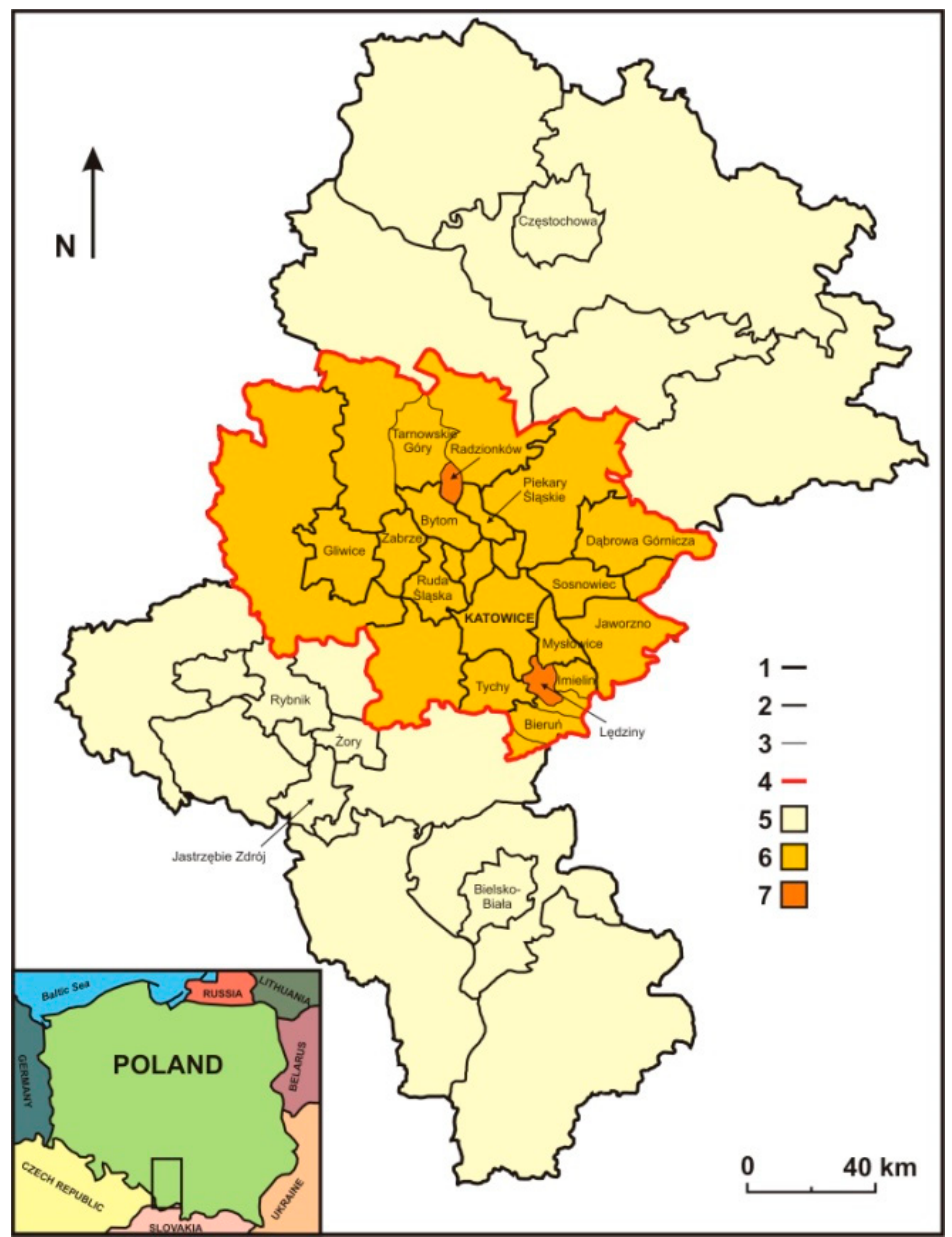
Figure 3. L ę dziny and Radzionków on the map of the Silesian province and the Katowice conurbation (illustration sourced by authors). Explanations: 1—Silesian province boundary; 2—county boundaries; 3—commune boundaries; 4—Katowice conurbation boundaries; 5—area of the Silesian province outside the Katowice conurbation; 6—area of the Katowice conurbation; and 7—towns of L ę dziny and Radzionków discussed in the paper.